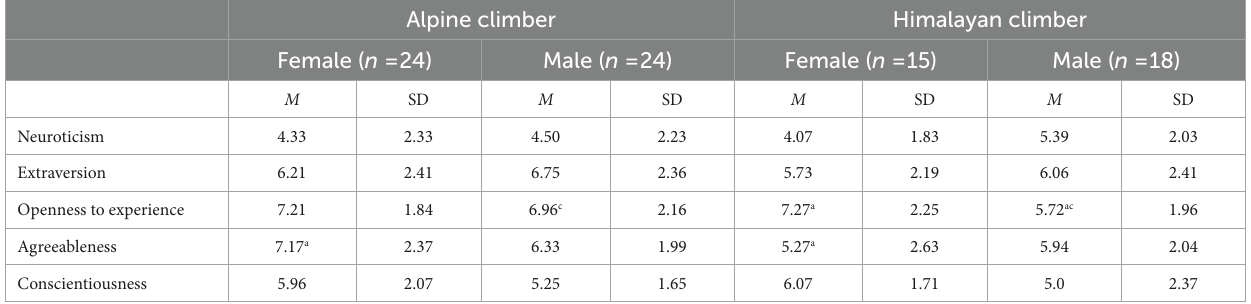
TABLE 4 Mean values and standard deviations with pairwise comparisons tests for simple effects.